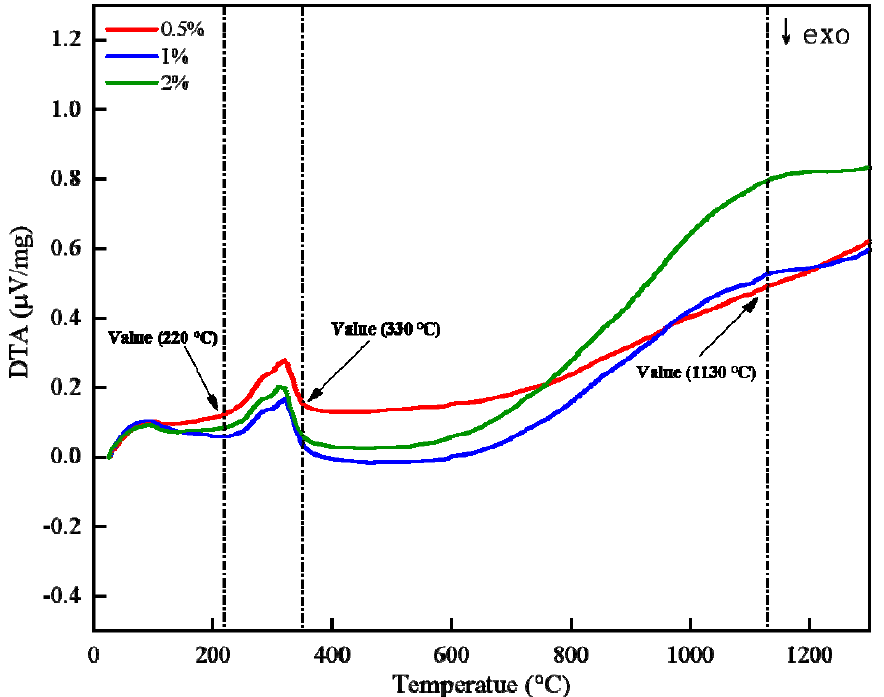
Figure 14. DTA curve of limonite with different bentonite ratio.